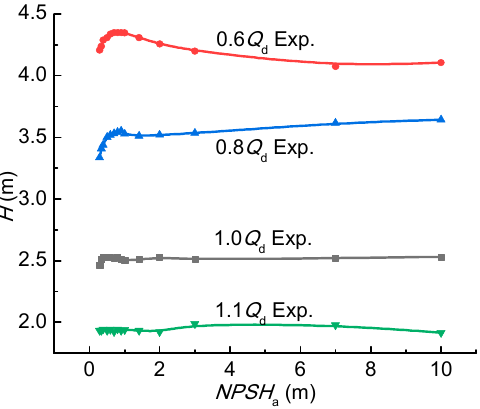
Figure 7. Cavitation performance of the inducer under different flow conditions.